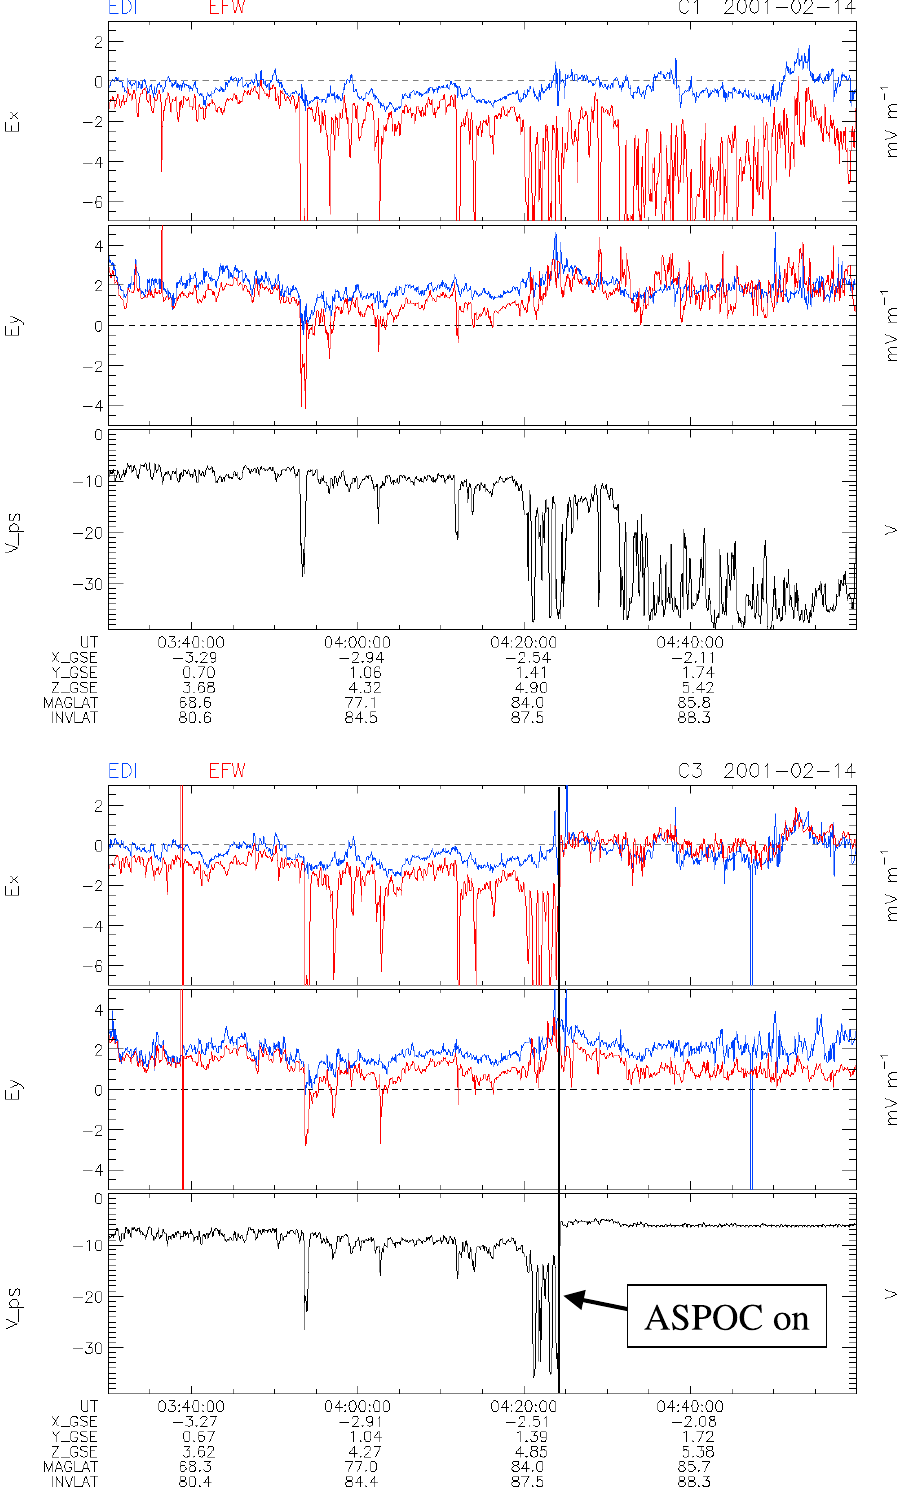
Fig. 13. Comparison of EFW (red) and EDI (blue) electric field spin plane components (DSI coordinates, close to GSE) for an event with a spurious electric field in the EFW data, for SC1 and SC3. On SC3, the artificial potential controller ASPOC is turned on at 04:24 UT, immediately alleviating the spurious E X in the EFW data on this spacecraft.